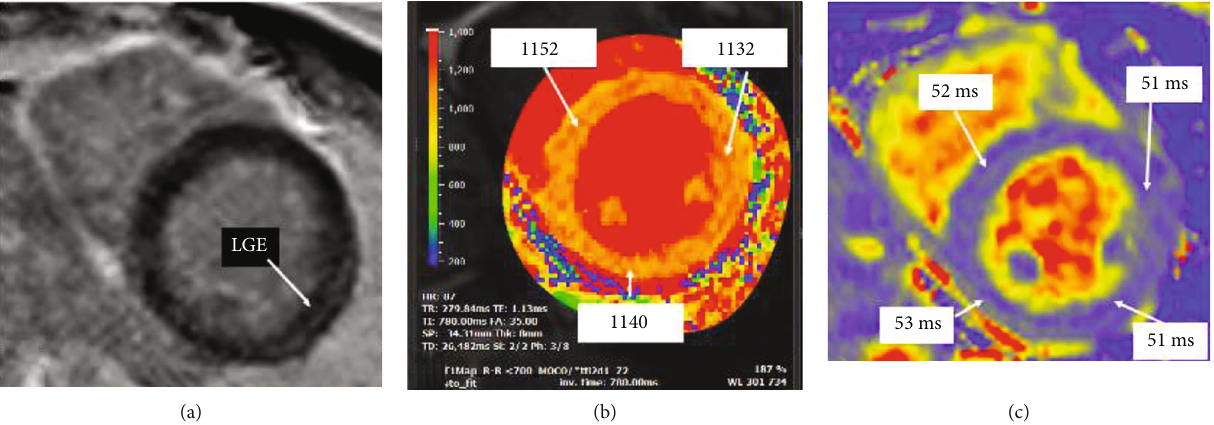
Figure 2: Tissue characterization on presenting cardiac MRI. Subtle stripe of epicardial LGE noted in the lateral wall (a). The native T1 relaxation time is di ff usely elevated throughout the myocardium (ULN for this 1.5 Tesla magnet is 1010ms), suggestive of di ff use in fl ammation (b). The native T2 relaxation time is mildly elevated throughout the myocardium and highest in the inferior wall (ULN: 50ms), suggestive of edema (c). Abbreviations: LGE: late gadolinium enhancement; ULN: upper limit of